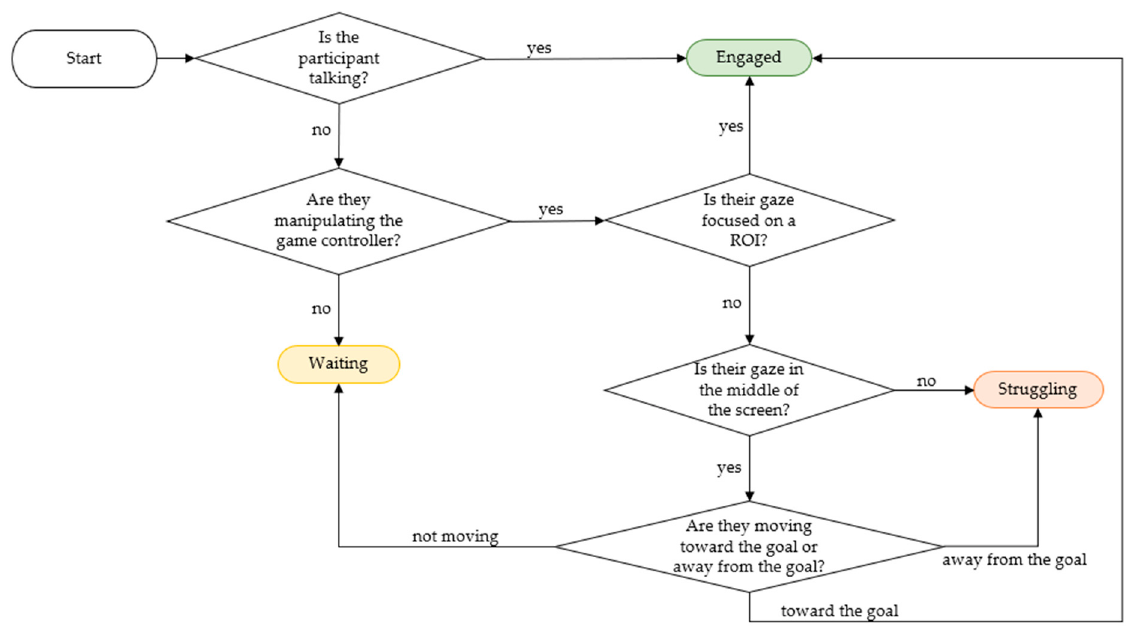
Figure 3. Flow chart for manual data annotation.